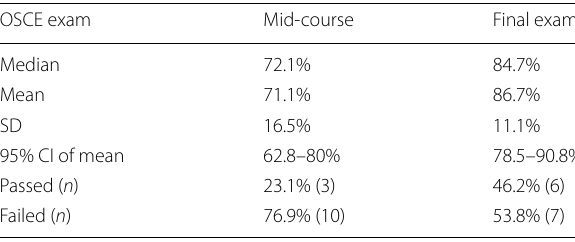
Table 4 Summary of OSCE exam scores for trainees at